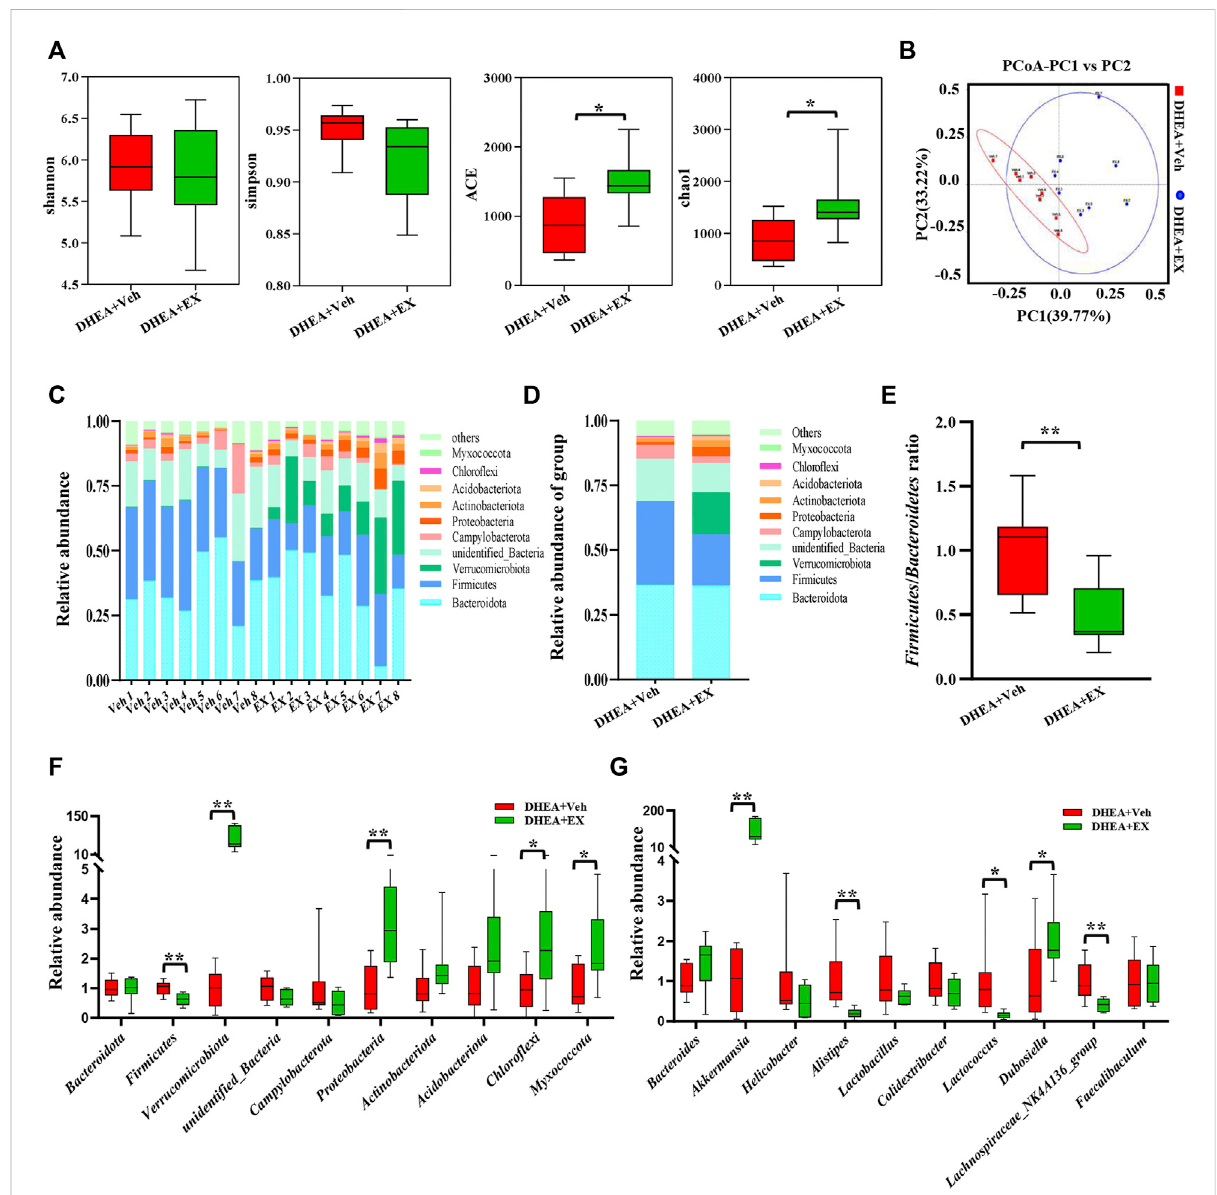
FIGURE 6 Enoxacin treatment modi fi ed the structure and composition of the gut microbiota in PCOS. (A) α -diversity of the gut microbiota between the vehicle and enoxacin groups, as indicated by the Shannon, Simpson ACE, and Chao1 indices. (B) Principal Coordinate Analysis (PCoA) based on the Bray Curtis distance algorithm. (C) Taxonomic composition of each mouse at the phylum level. (D) Taxonomic composition of two group at the phylum level. (E) Firmicutes/Bacteroidetes ratio. (F) Relative abundance of gut microbiota on phylum level. (G) Relative abundance of gut microbiota on genus level. Values are represented as the mean ± SE. n = 5 – 6. P values were determined by two-tailed Student ’ s t -test. * p < 0.05, ** p < 0.01. DHEA, dehydroepiandrosterone; Veh, vehicle; EX,